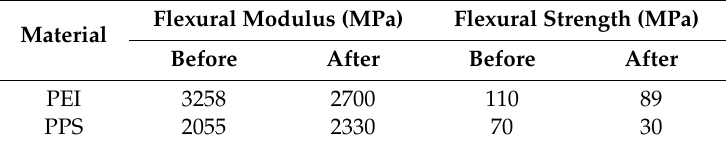
Table 8. Flexural mechanical properties of the selected materials before and after the aging test.